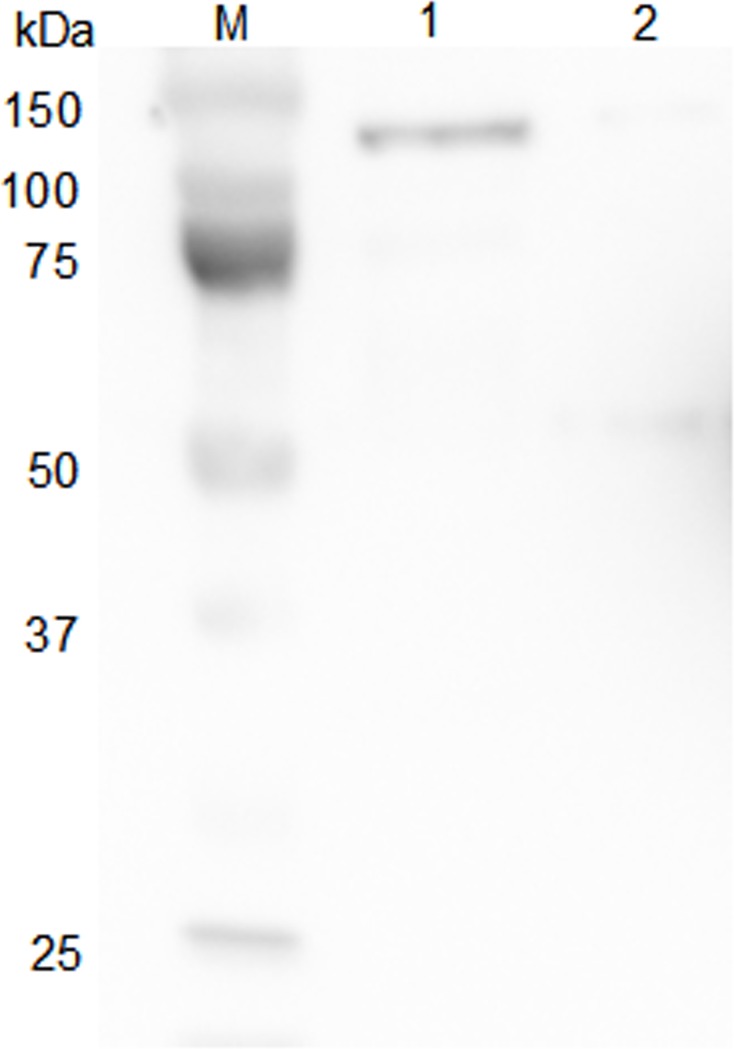
Western blot of OMVs proteins reacted with corresponding mouse anti-sera.Lane M: protein marker. Lane 1: Apxr-OMV. Lane 2: OMV-Empty. The arrow indicates the destination band.